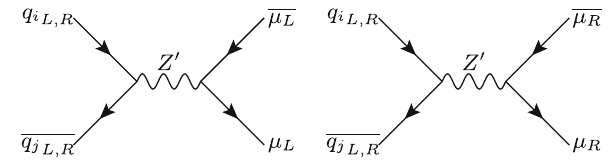
Fig. 2 Feynman diagrams of tree-level Z (cid:2) production in the LHC by the DTFHM followed by decay into muons, where q i , j ∈ { u , c , d , s , b } aresuchthatthecombination q iL q jL or q i R q j In the DTFHMeg, by far the dominant production mode is by q i = b L and q j = b L